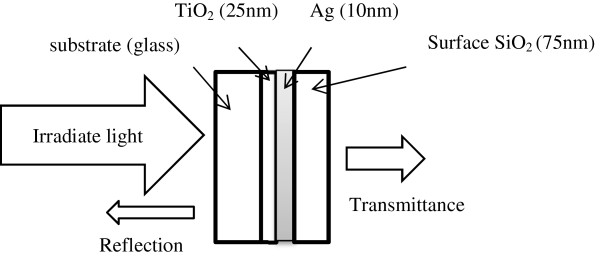
Structure of the transparent film (TiO2/Ag/SiO2, TAS). Each layer was fabricated by E-beam evaporation with IAD.